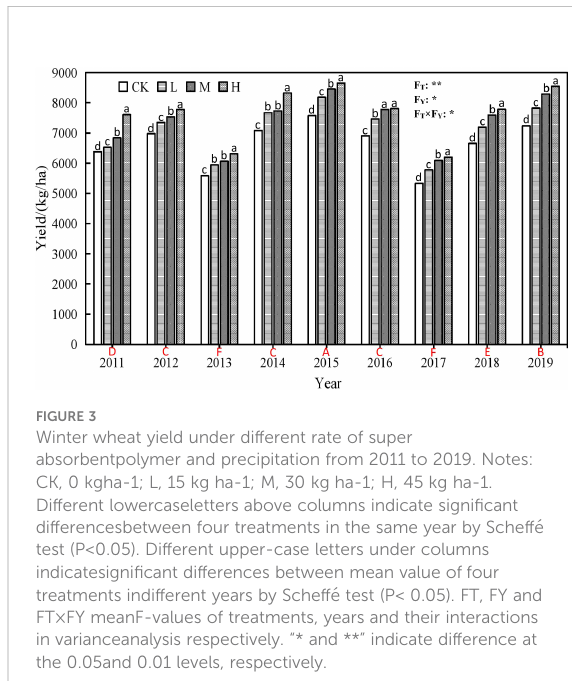
FIGURE 3 Winter wheat yield under different rate of super absorbentpolymer and precipitation from 2011 to 2019. Notes: CK, 0 kgha-1; L, 15 kg ha-1; M, 30 kg ha-1; H, 45 kg ha-1. Different lowercaseletters above columns indicate signi fi cant differencesbetween four treatments in the same year by Scheffe ́ test (P<0.05). Different upper-case letters under columns indicatesigni fi cant differences between mean value of four treatments indifferent years by Scheffe ́ test (P< 0.05). FT, FY and FT×FY meanF-values of treatments, years and their interactions in varianceanalysis respectively. “ * and ** ” indicate difference at the 0.05and 0.01 levels,